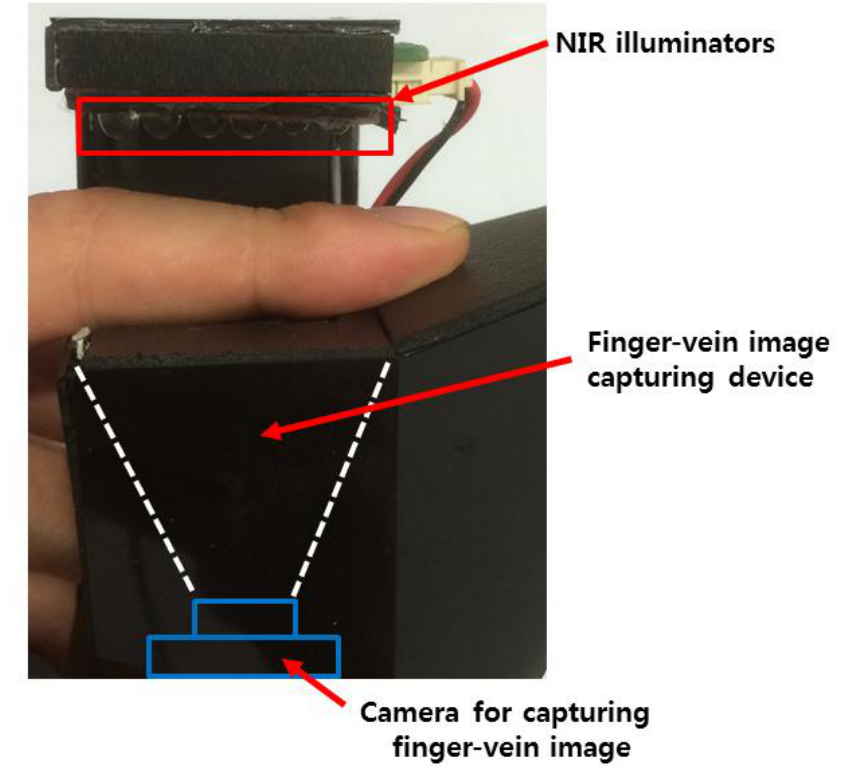
Figure 17. The image capture device made in the laboratory, which was used to obtain the finger-vein images in database